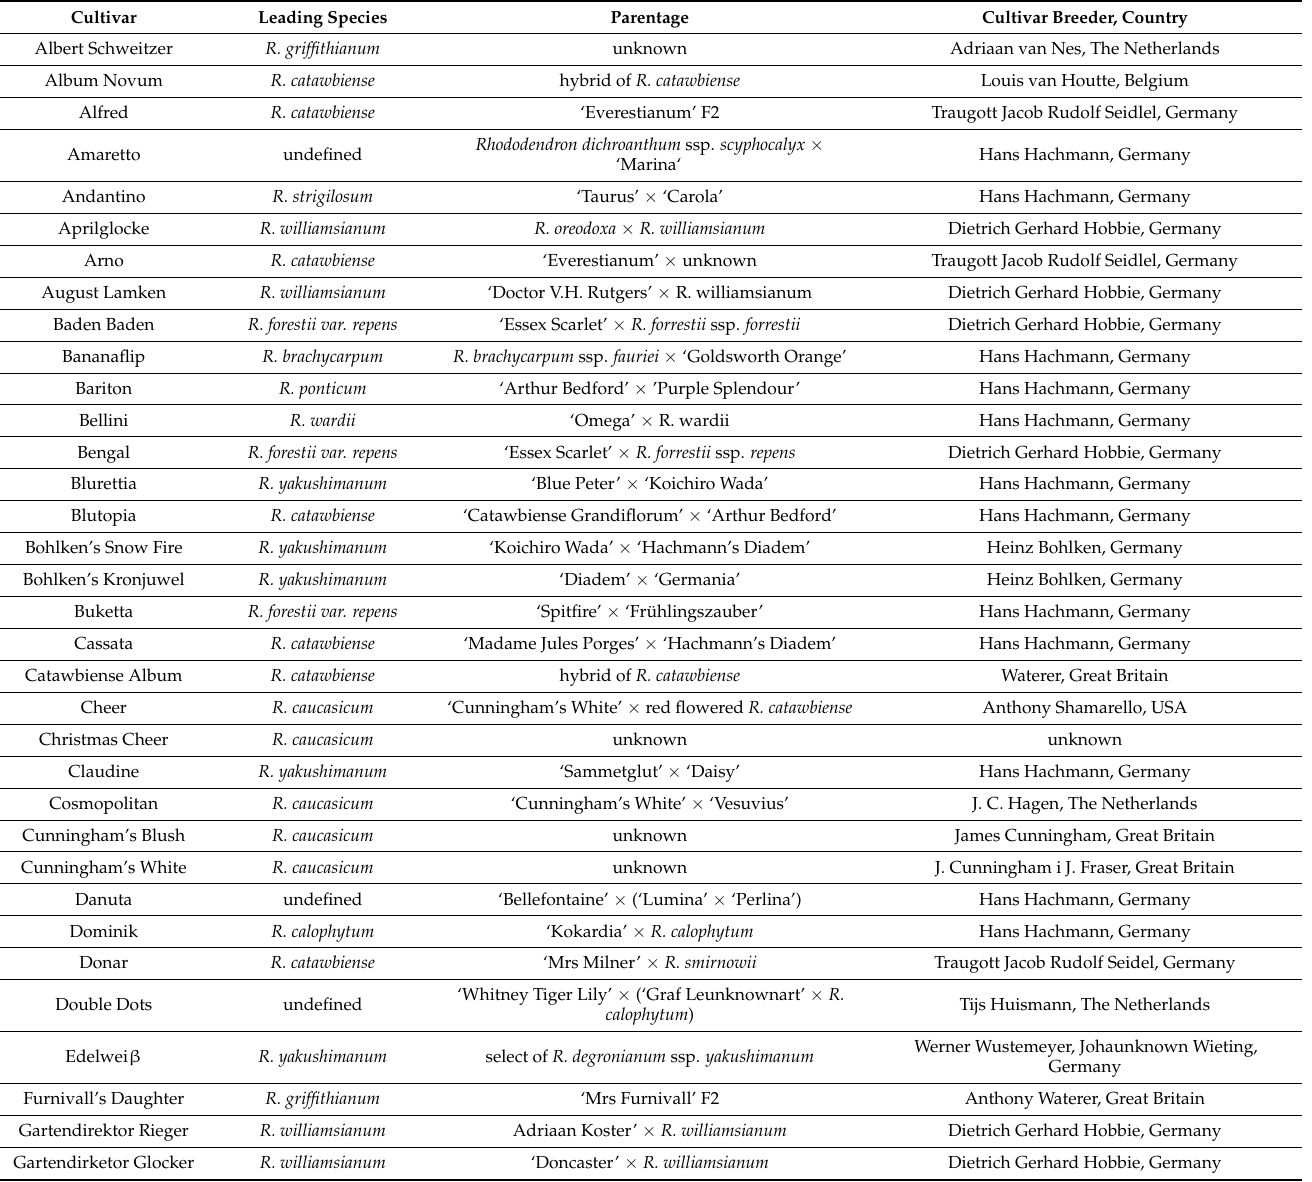
Table 1. Cultivars of rhododendrons used in the experiment, their leading species, parentage and